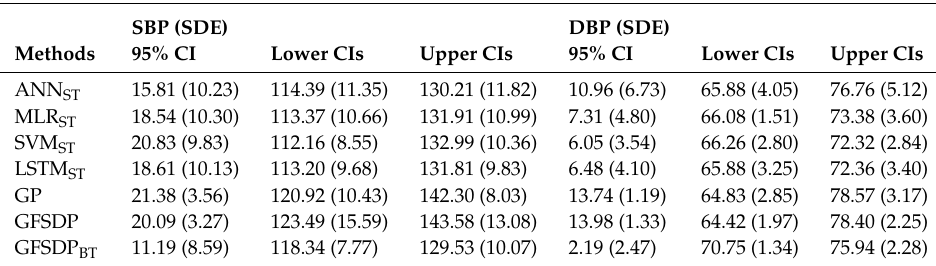
Table 10. Summary of the CIs for SBP and DBP compared to the proposed and conventional methods, where ST denotes the Student’s t-distribution and BT is the bootstrap